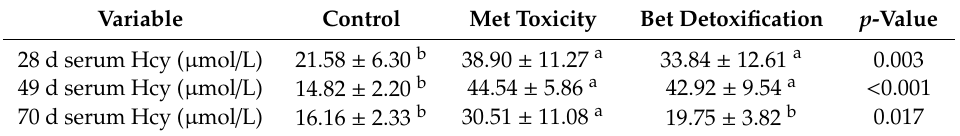
Table 3. E ff ect of betaine on serum biochemical indices in geese with hyperhomocysteinemia.